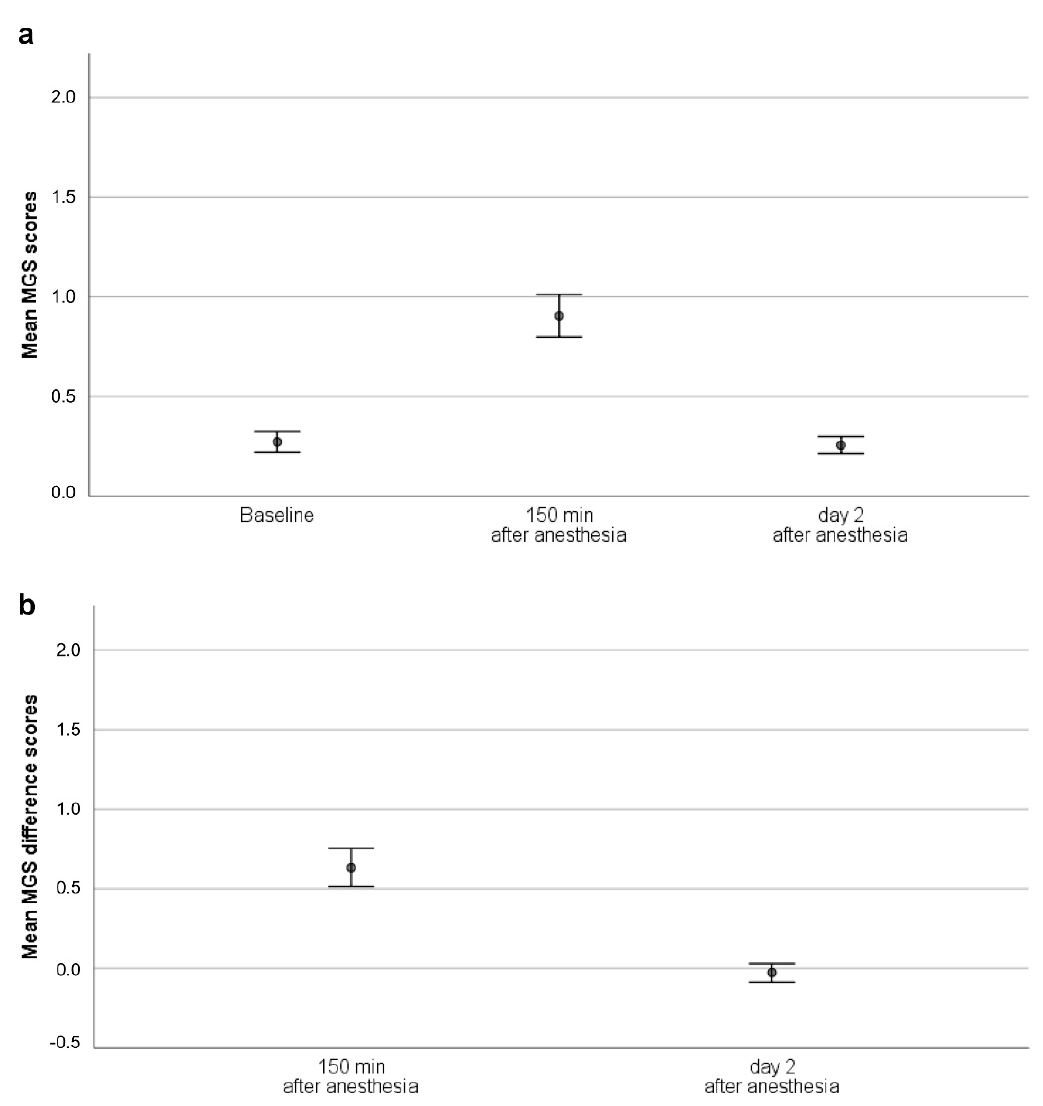
Figure 1. MGS scores (mean, 95% confidence interval). ( a ) Mean MGS scores, ( b ) Mean MGS difference scores. Please note that data were derived from animals that received either no, one, or six anesthesia.